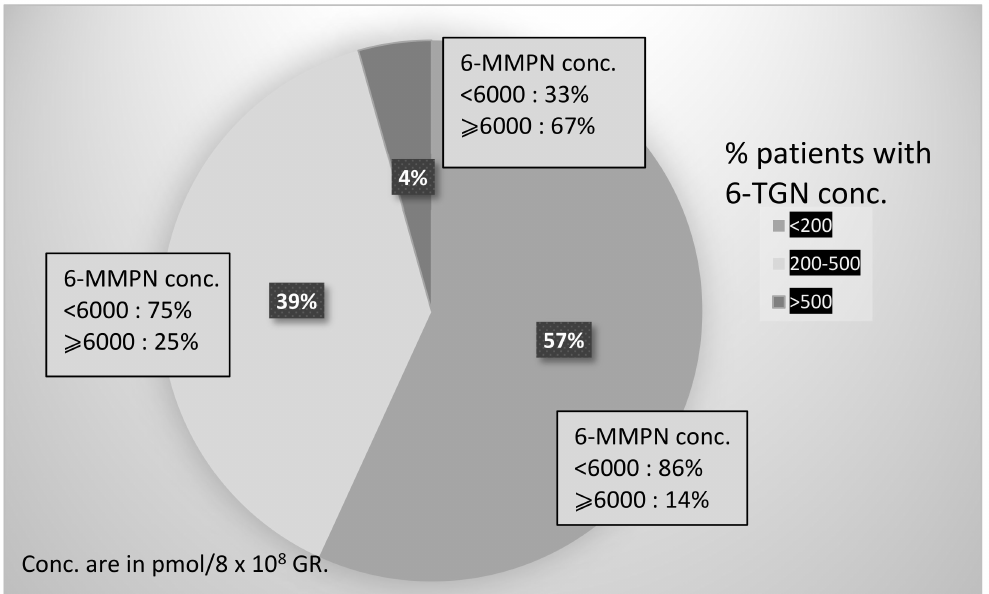
Figure 3. Percentage of patients with 6-TGN or 6-MMPN concentrations within or outside of the recommended therapeutic